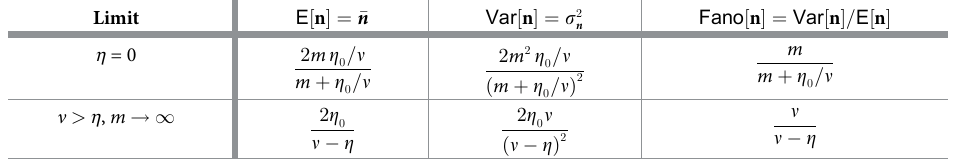
Table 2. Mean and variance of TE load in the absence of selection. Limit E ½ n � ¼ � n